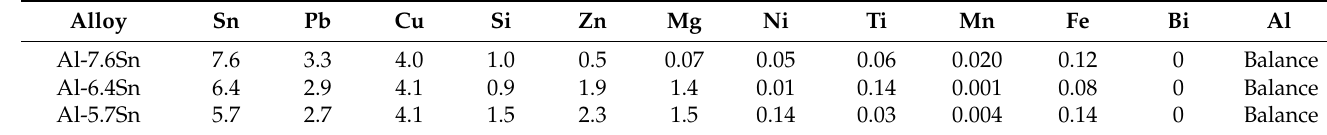
Table 2. The chemical compositions (wt.%) of the investigated